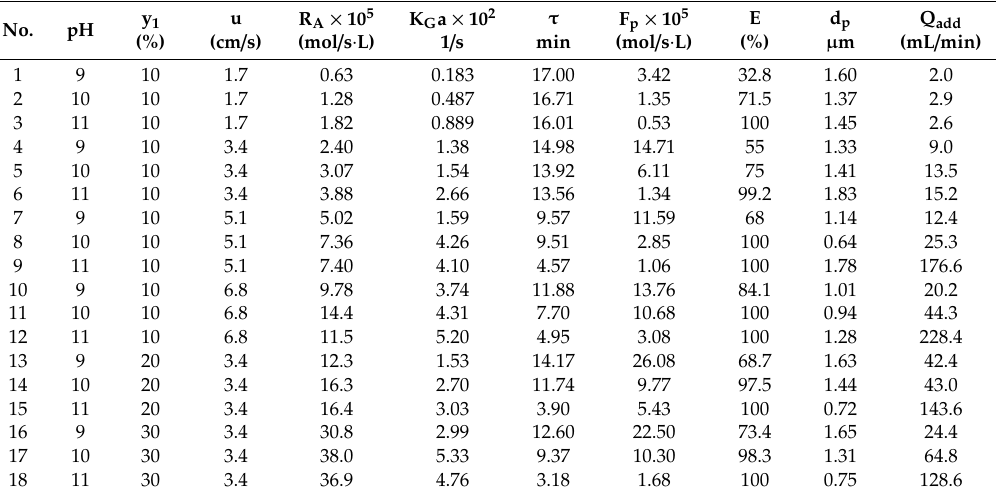
Figure 2. Variation in CO 2 concentration at the outlet with time at different pH values. (CO 2 = 10 %, Q g = 4 L/min). Table 2. The data obtained in the experiment.